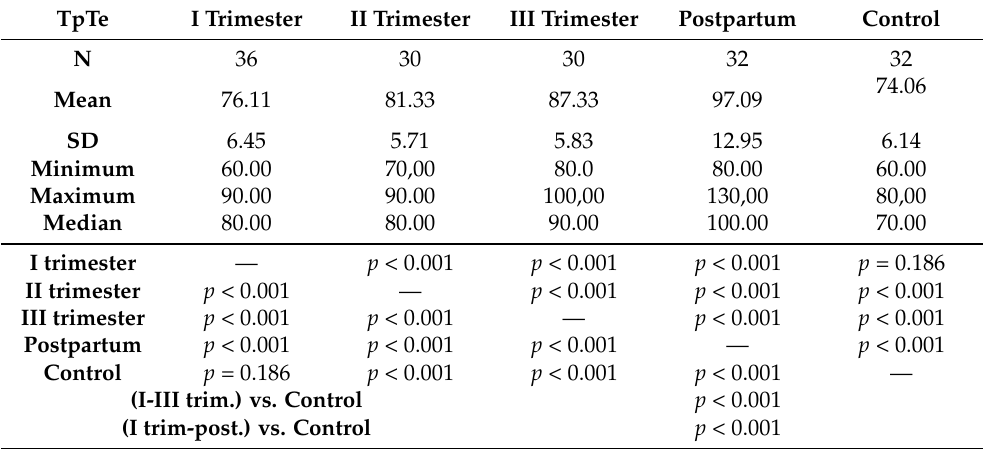
Table 2. TpTe interval in the 1st, 2nd, and 3rd trimester of pregnancy, in the puerperium and in the control group.